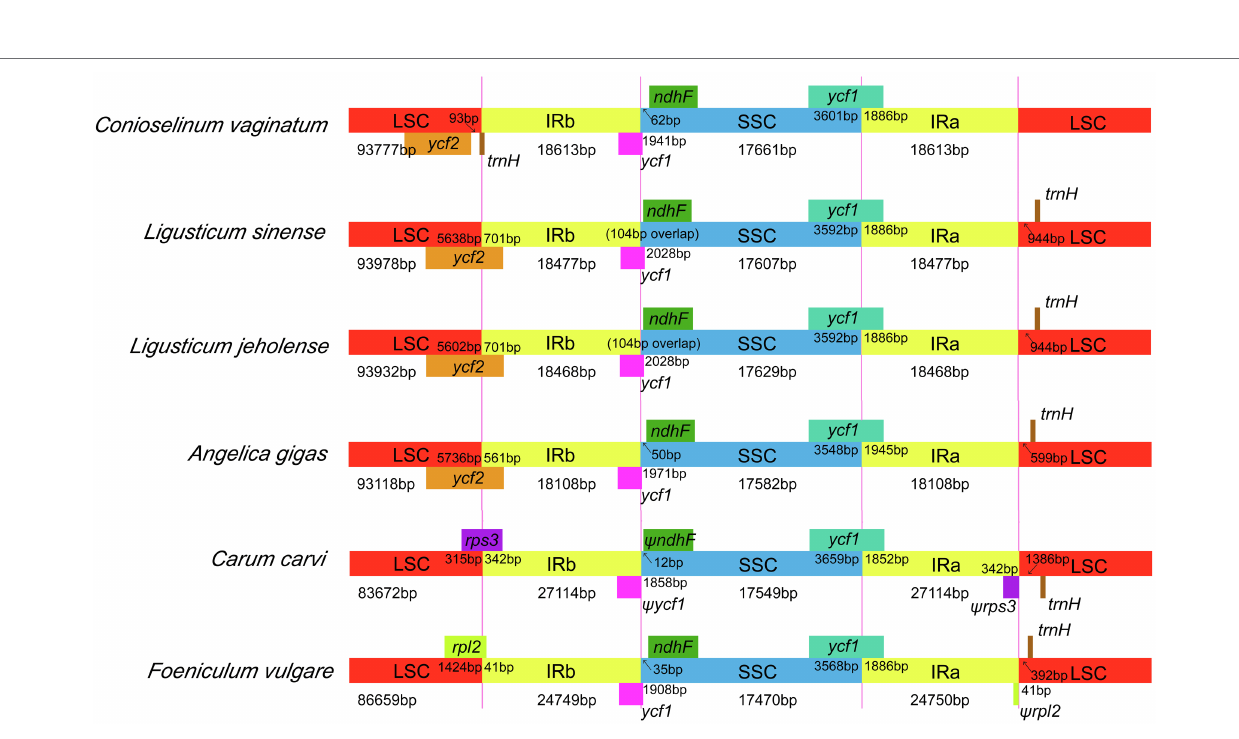
FIGURE 5 | The borders of LSC, SSC, and IR regions among six chloroplast genomes. The number above the gene features means the distance between the ends of genes and the borders